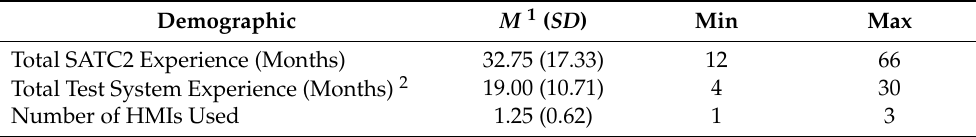
Table 2. Demographic Characteristics of User Testing Participants. Demographic M 1 ( SD ) Total SATC2 Experience